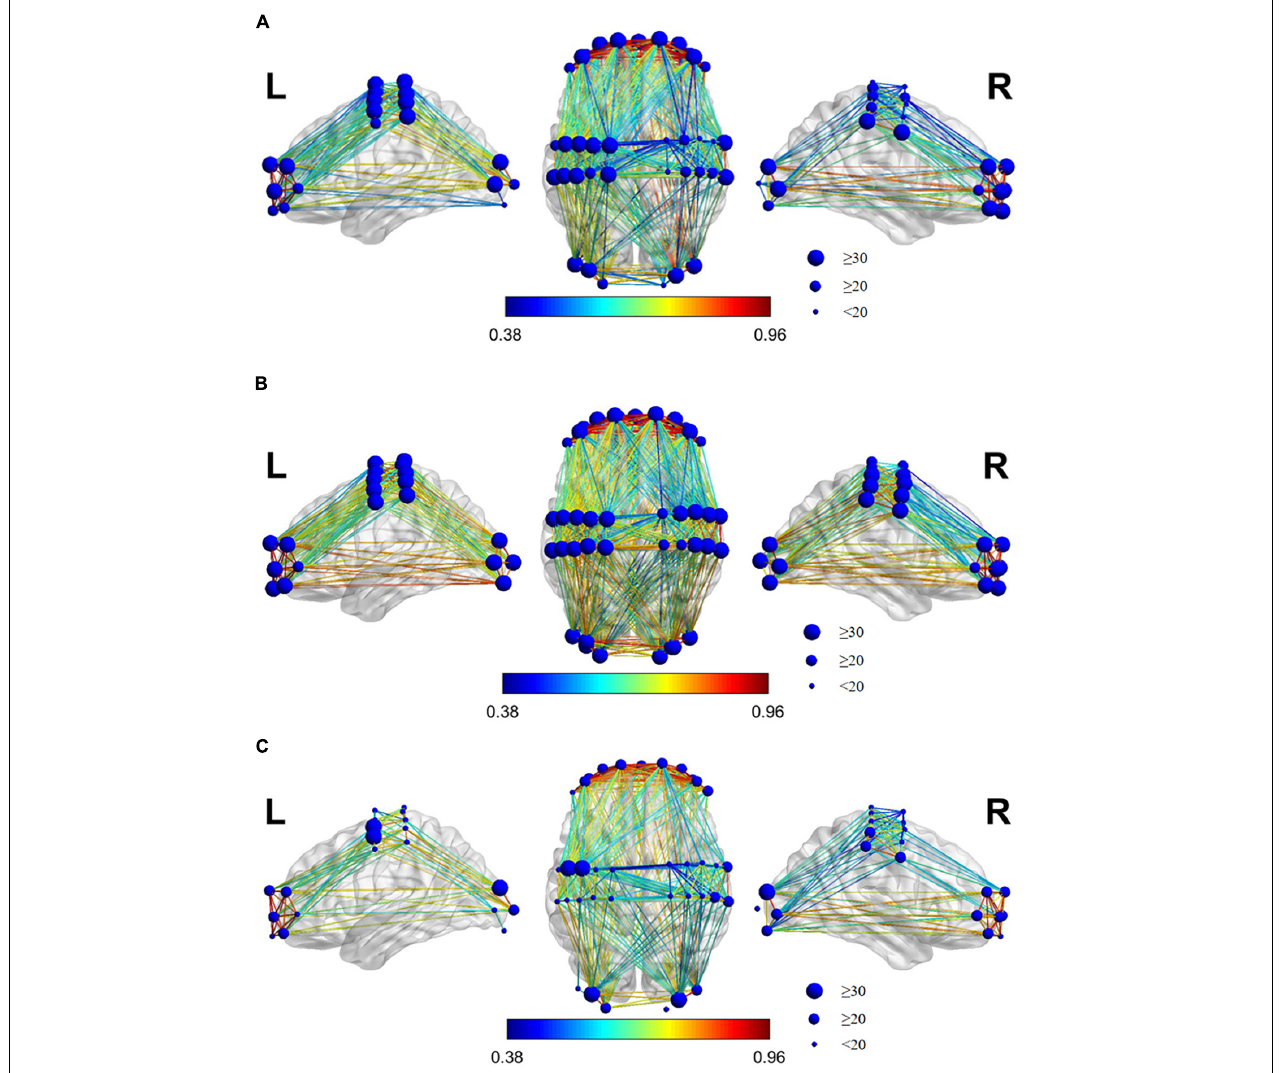
FIGURE 7 | Brain FC map of the state of each task. (A) Resting, (B) Grasping, (C) VR Grasping. If there is a connection line between the two channels, it shows a FC between the two channels with a significant WPCO value. The redder the connection in the picture, the stronger the FC between the two channels, and the bluer the connection, which means the weaker the FC between the two channels. The size of the blue dot on the channel location reflects the number of connection between the channel and all other